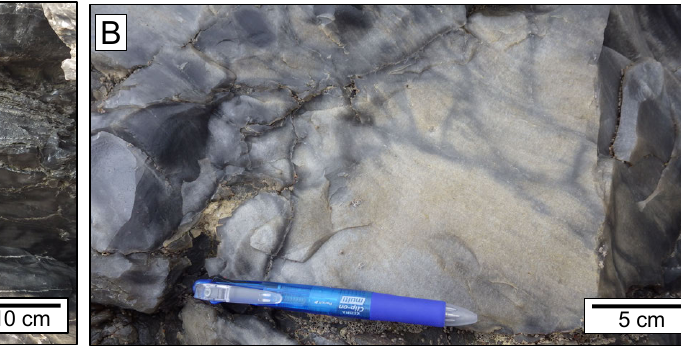
Figure 10: [A] Fracture network developed in the mas- sive obsidian. Note the obsidian along the fracture shows black color, while the obsidian away from the fracture shows light gray color. [B] Fracture network is obscured and disappear, while the two-colored obsidian remains preserved. [C] Flow bandings developed from the plastic deformation of the two-colored